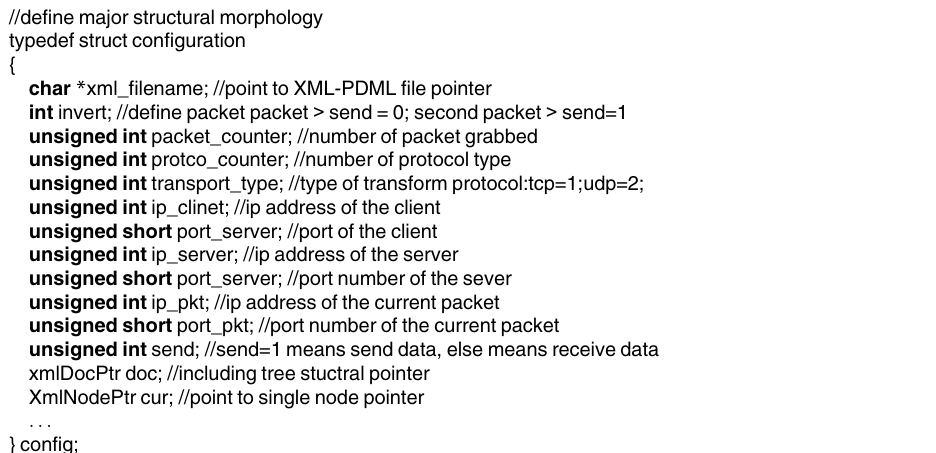
Table 2. Design of structural morphology. //define major structural morphology typedef struct